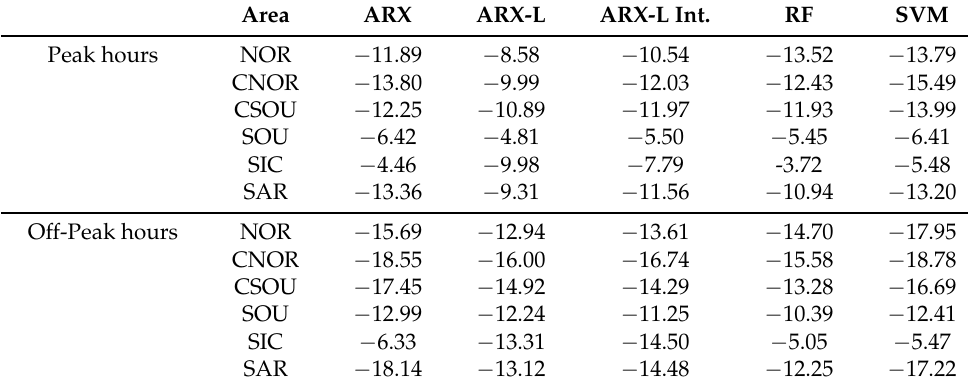
Table A3. Percentage variation of the mean values of MAE over peak and off-peak hours with respect to the case in which no lagged values of the dependent variable were included in the regressors